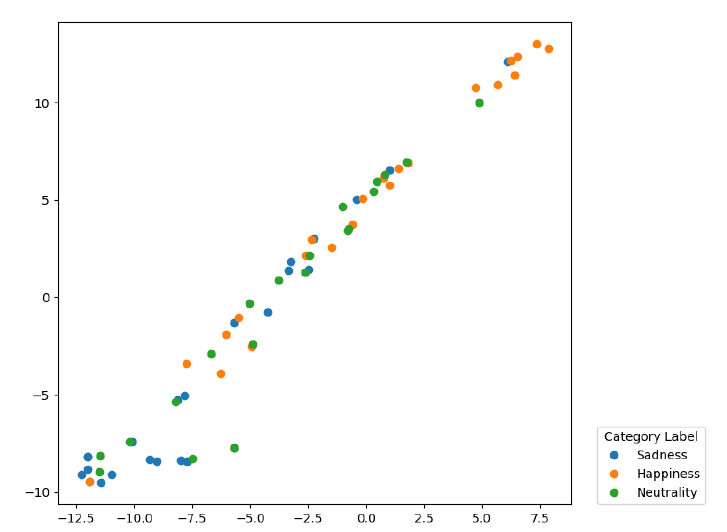
Figure 14. Visualization for distributions of deep emotion features of the student model on